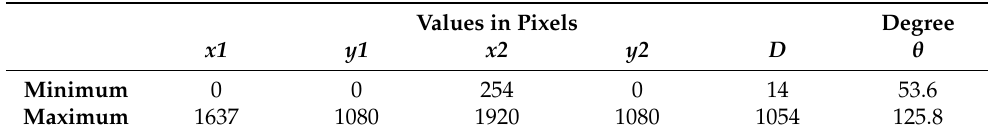
Table 5. Sea horizon line statistics.